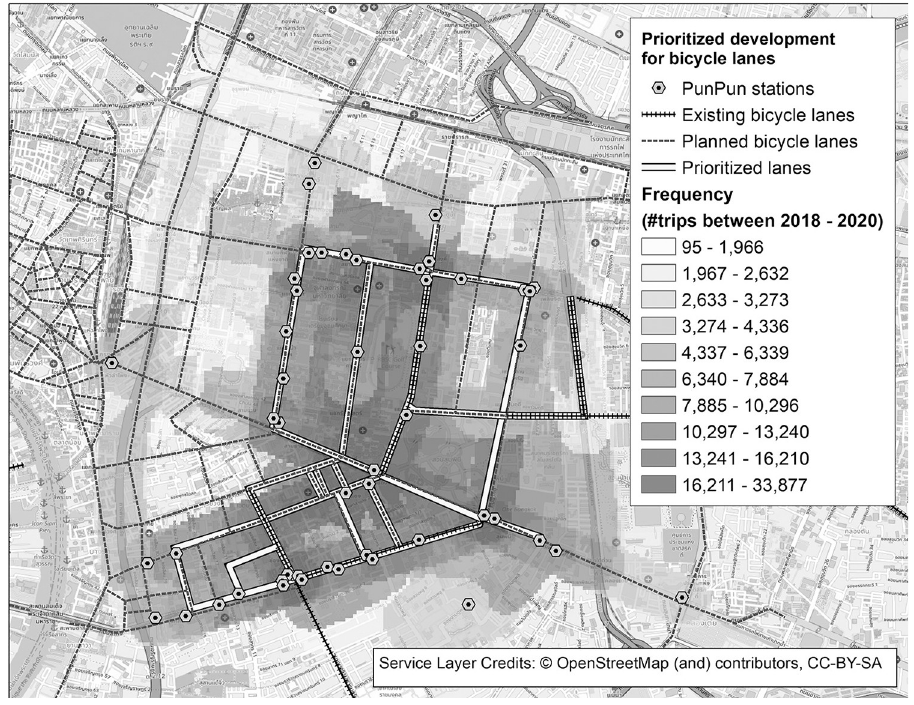
Fig 13. Frequently used streets and a priority for a bicycling infrastructure development. The figure contains a base map and data from OpenStreetMap and OpenStreetMap Foundation, which is made available under the Open Database